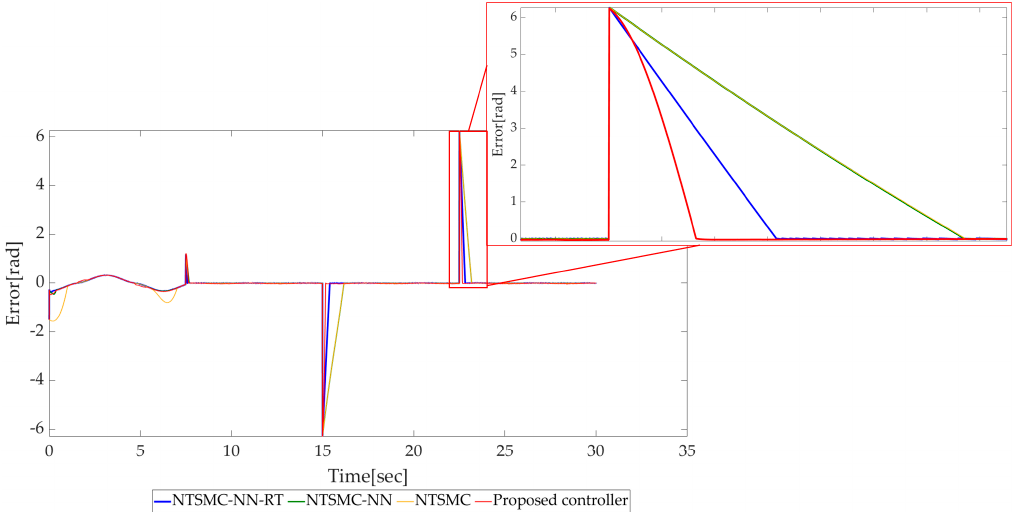
Figure 22. Comparing θ 1 error for mixed input.